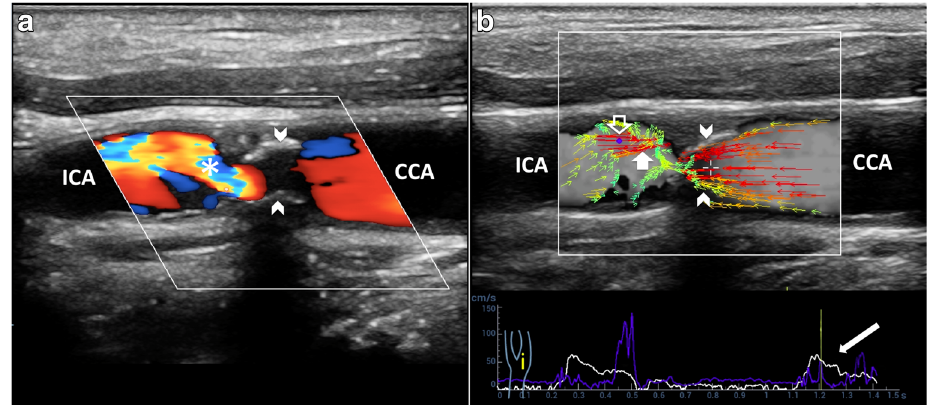
bundled( arrowheads ) while enteringthe stenosis.Distally, turbulentflow coded by green/orange vectors, randomly oriented, and by reversed red vectors ( short white arrow ). Blue dot ( void arrow ): max velocity point. CCA = Common carotid artery. ICA = Internal carotid artery